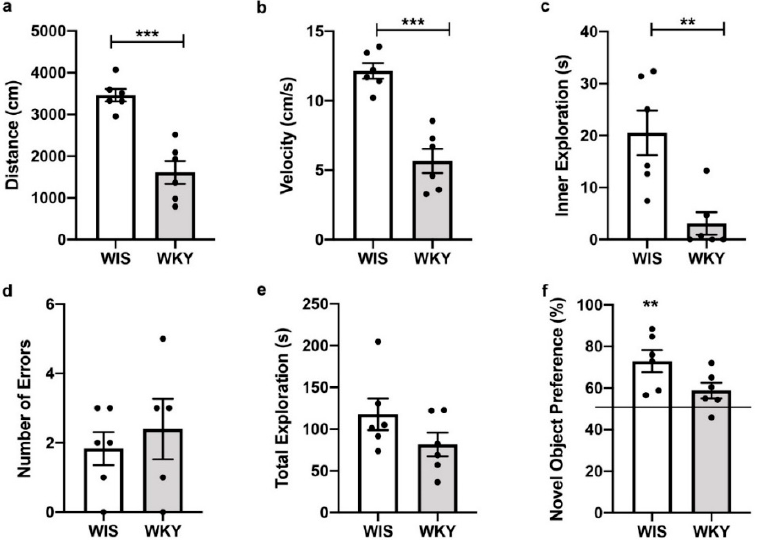
Figure 1. WKY animals show a behavioral phenotype consistent with depression. In the open field arena, WKY animals ( a ) travelled a shorter distance, ( b ) had a slower velocity, and ( c ) spent less time exploring the inner portion of the arena. In the working memory task, radial arm maze, ( d ) and WIS and WKY had an equivalent number of errors. In the short-term memory task, for novel object recognition, although WIS and WKY ( e ) spent a similar amount of time exploring objects, ( f ) WIS showed a statistically significant preference for the novel object, whereas WKY did not show a preference for the novel object. ** p < 0.01, *** p < 0.001.